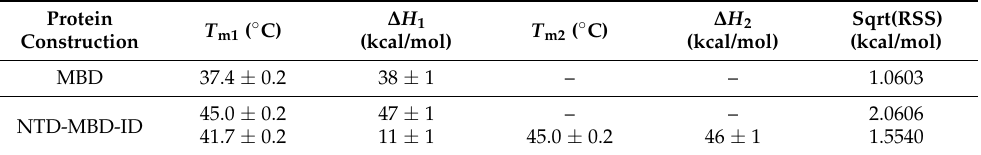
Table 2. Thermal unfolding parameters for MBD and NTD-MBD-ID at pH